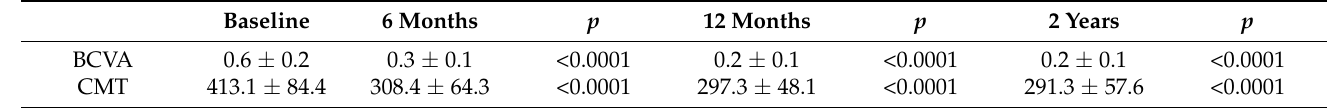
Table 2. BCVA and CMT at baseline and 2 years